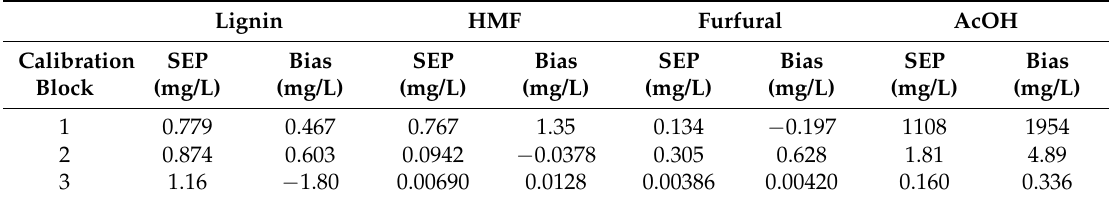
Table 3. SEP and bias values of the application of calibrations from data blocks 1 to 4 to data block 4.